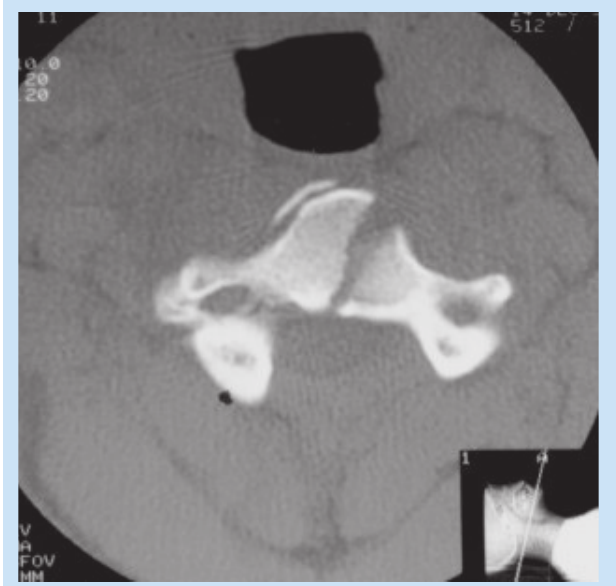
Fig. 2. Axial computed tomographic (CT) scan of the same patient shows the oblique fracture not well appreciated on lateral